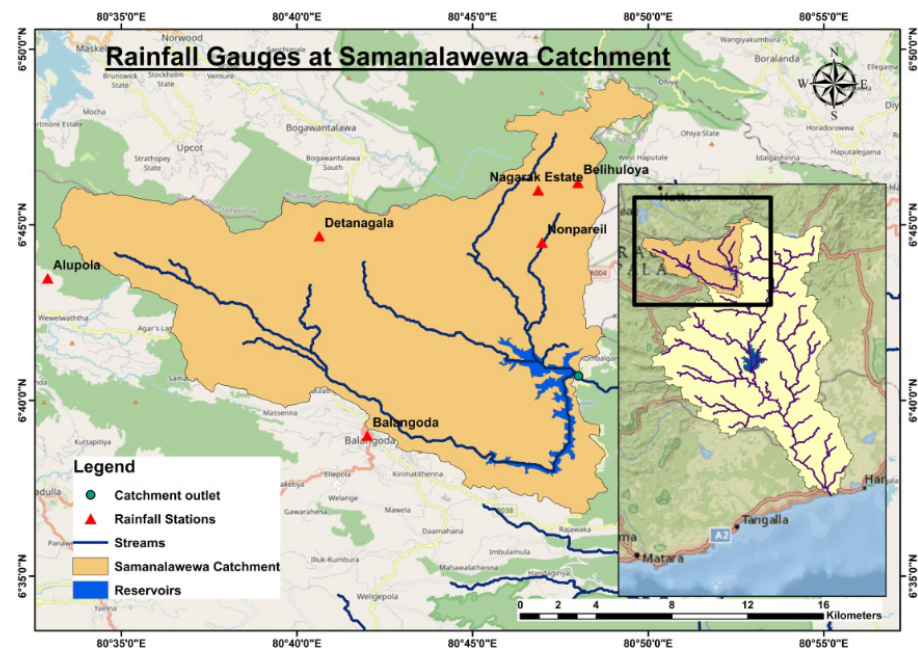
Figure 1. Rainfall gauges at Samanalawewa